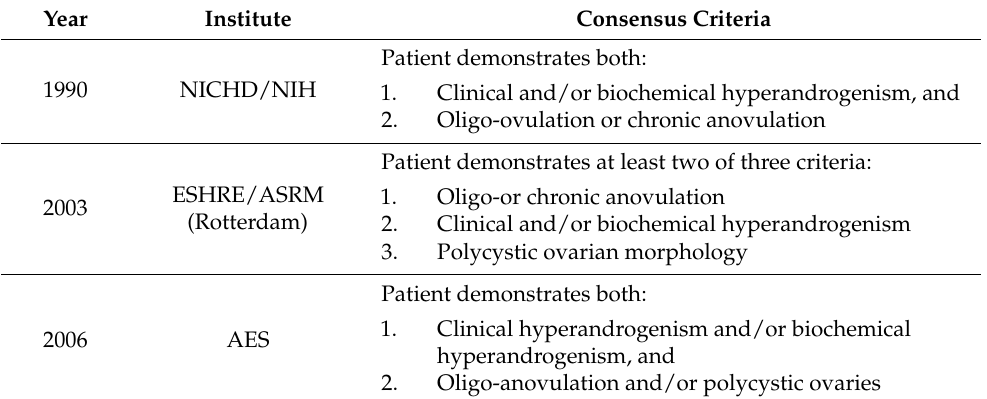
Table 1. Diagnostic Criteria of Polycystic Ovary